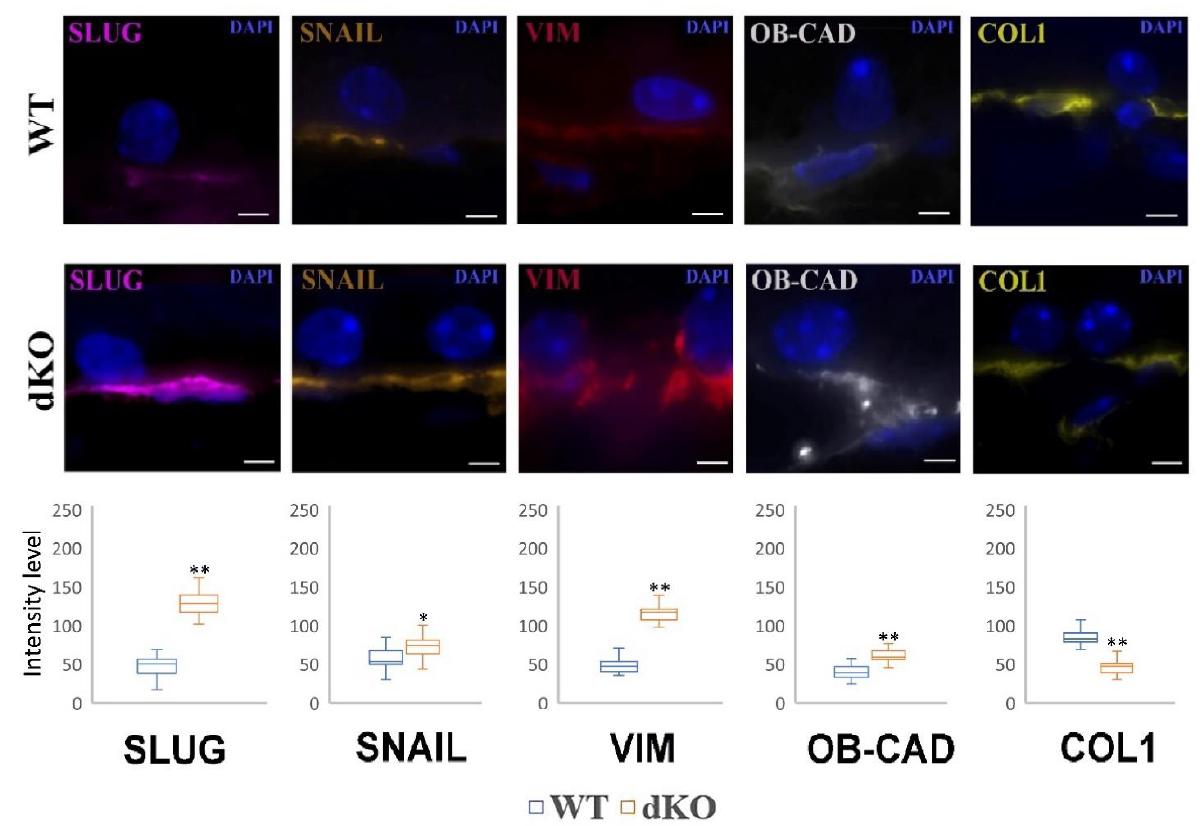
Figure 5. Confocal microscopy analysis of the immunoreactivity of mesenchymal markers in the retinal pigment epithelium (RPE) of one-year-old NFE2L2/PGC-1 α dKO mice as compared with their wild-type (WT) counterparts. Semiquantitative comparative densitometric analysis done by ImageJ of the immunoreactivity of Slug, Snail, vimentin, OB-cadherin (OB-CAD) and collagen-1 (COL1) in 1- µ m parasagittal sections of RPE. Alexa Fluor secondary antibodies were used to detect specific mesenchymal markers. DAPI was used to stain the nuclei of RPE cells. Scale bar: 5 µ m. The number of puncta specific to a particular marker is presented in plots in the lower panels. Twenty-five pictures were analyzed for each animal. * p < 0.05, ** p < 0.001 (Mann-Whitney U-test).